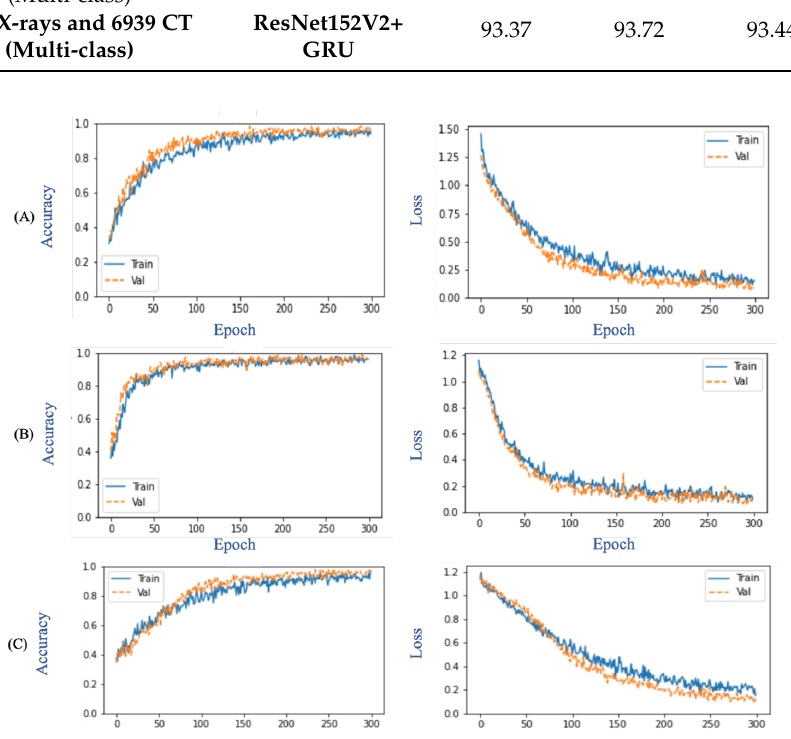
Figure 5. Evaluation metrics of CNN-RNN network: ( A ) ResNet152V2 with GRU in original image, ( B ) VGG19 with LSTM in normalized image technique and ( C ) DenseNet121 with LSTM in normalized image